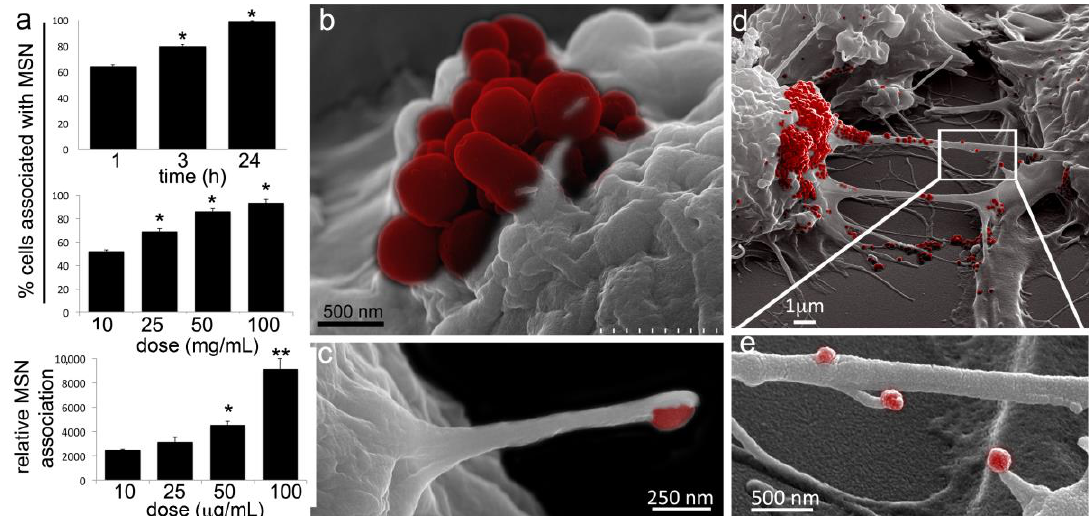
Figure 2. Murine macrophages robustly internalize MSN. ( a ) Flow cytometry analysis of cell association with fluorescent MSNs following incubation with 10 µ g / mL DyLight 488-conjugated-MSN for 1, 3, or 24 h at 37 ◦ C (top graph). Percent of cells positive for fluorescent MSN association (middle graph) or mean fluorescent intensity (MFI; bottom graph) of cells 1 h after the addition of 10 − 100 µ g / mL MSN. ( b – e ) Pseudo-colored scanning electron microscopy (SEM) images of RAW 264.7 cells 1 h after the addition of MSN (red) to the culture media. ( b ) Macrophage with a cluster of MSN (red) on the cell surface. ( c ) Cell filopodia with a bound MSN (pseudo-colored red) at the distal end. ( d ) MSN (red) on cell bodies and TNTs. ( e ) MSN (red) uptake by filopodia projecting from non-adherent cellular bridges (a.k.a. TNTs). * p < 0.05; ** p <